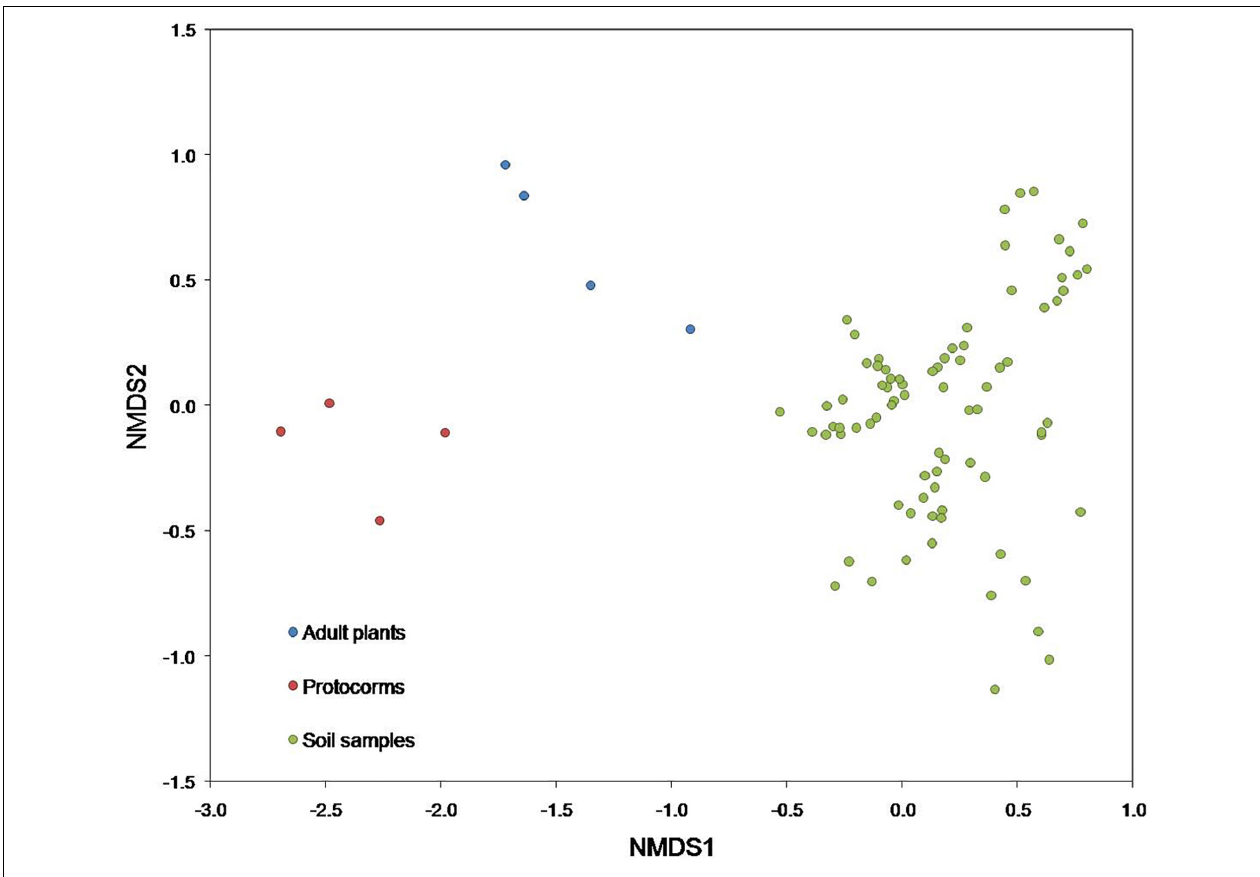
FIGURE 3 | Non-metric multidimensional scaling (NMDS) plot illustrating differences in fungal communities detected in protocorms, adult plants and soil samples. Each data point represents an individual protocorm (red), adult (blue), or soil (green)